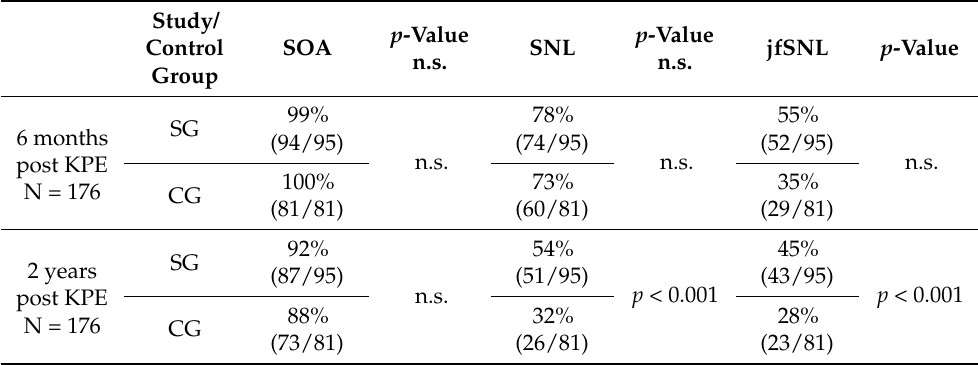
Table 1. Outcome after Kasai procedure with and without adjuvant budesonide therapy at six months and two years after the Kasai portoenterostomy